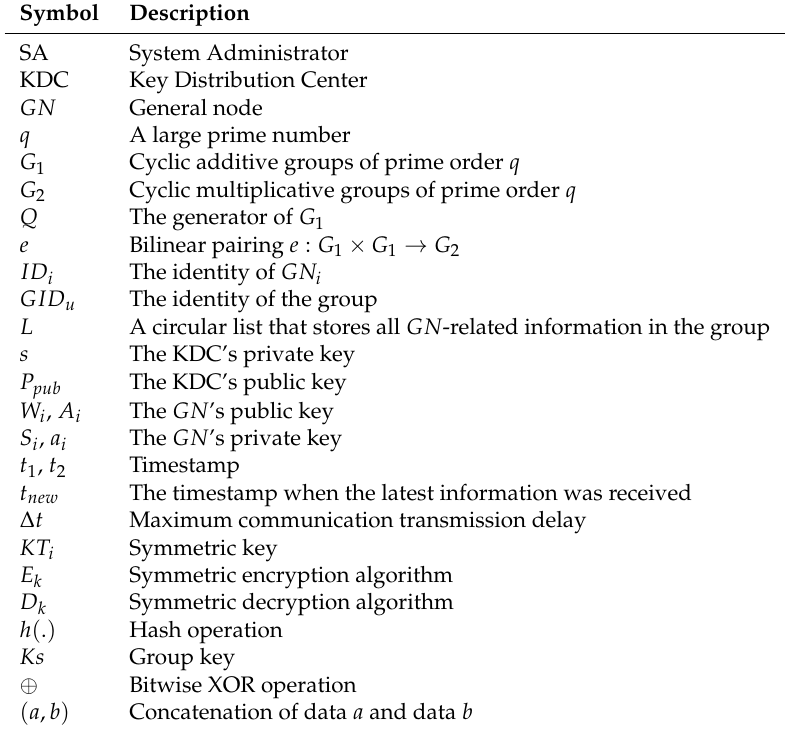
Table 1. Symbols used in our